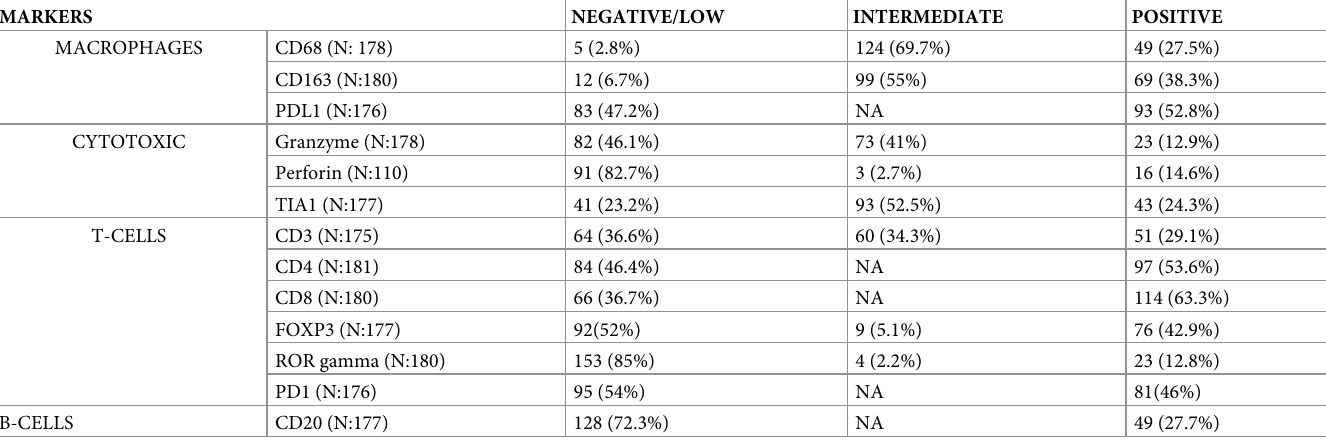
intense expression of active caspase 3) (79% vs . 45%), and a stroma richer in T-cells, cytotoxic T-cells, macrophages, PDL1-positive macrophages and B-cells (Table 6). Discussion MCC was originally described as a primary cutaneous neuroendocrine small-cell cancer with aggressive behavior [1]. It was subsequently noted that most MCC cases carried MCPyV, the frequency varying between 49% and 89%, depending on the extent of exposure to UV radia- tion and the detection technique [16]. Table 5. Main IHC markers for the stromal cells. MARKERS